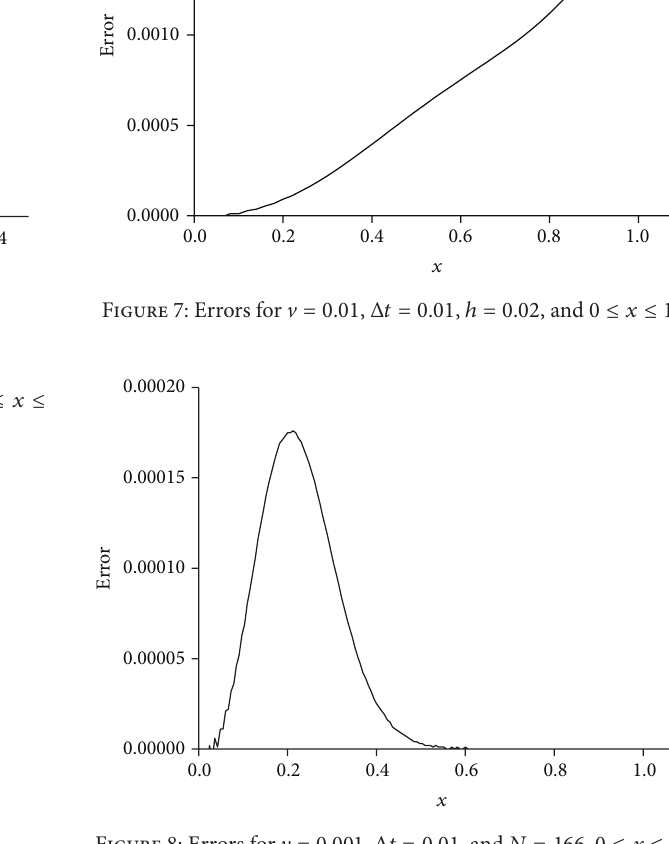
Figure 8: Errors for V = 0.001 , Δ𝑡 = 0.01 , and 𝑁 = 166 , 0 ≤ 𝑥 ≤ 1